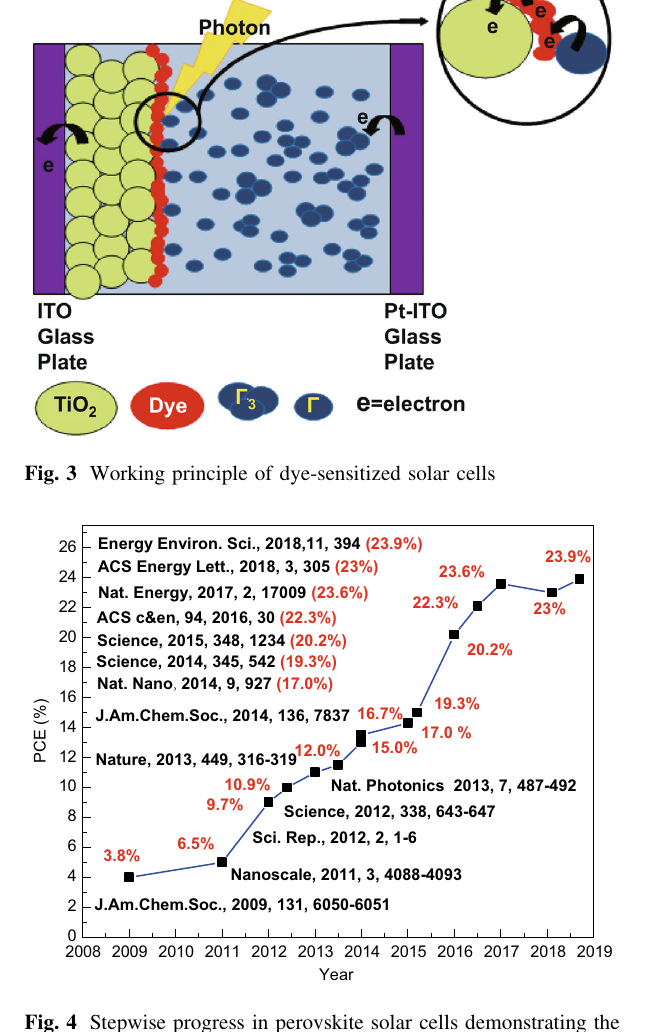
Fig. 5 Yearwise progress in perovskite solar cell research published by various journals (data collected from Web of